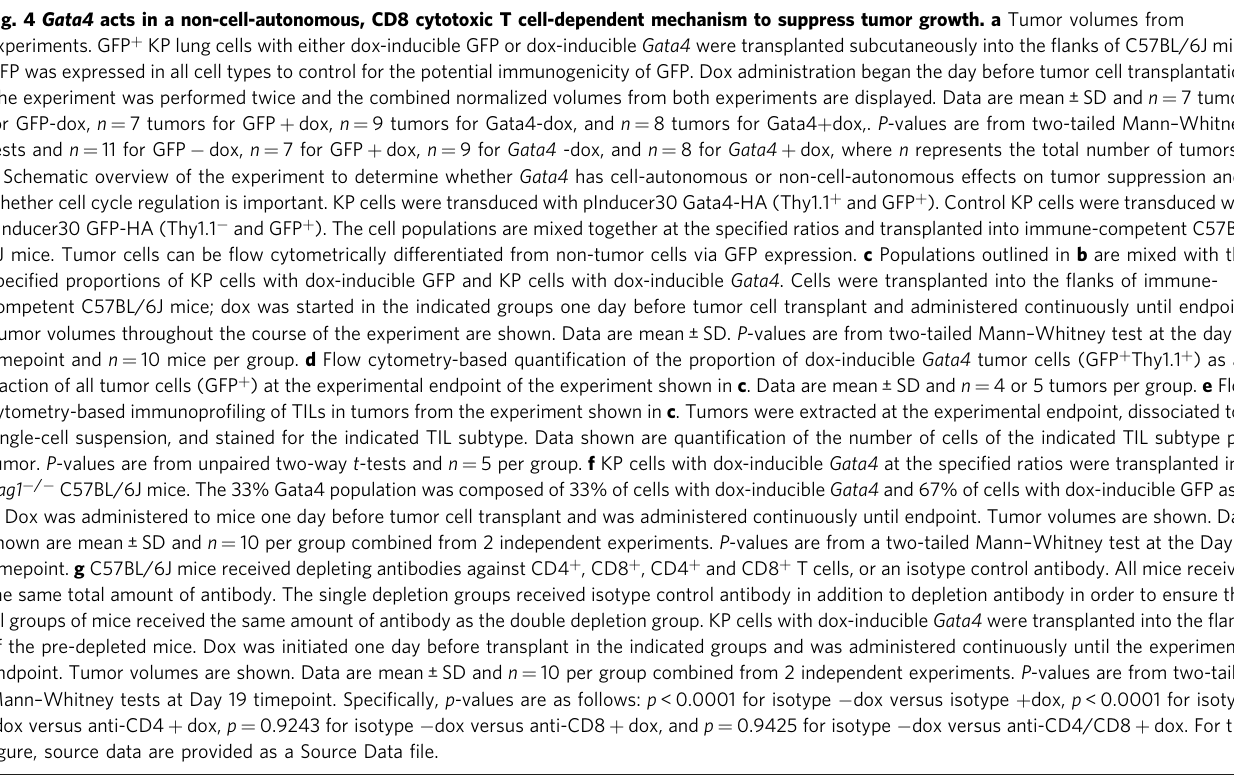
Fig. 4 Gata4 acts in a non-cell-autonomous, CD8 cytotoxic T cell-dependent mechanism to suppress tumor growth. a Tumor volumes